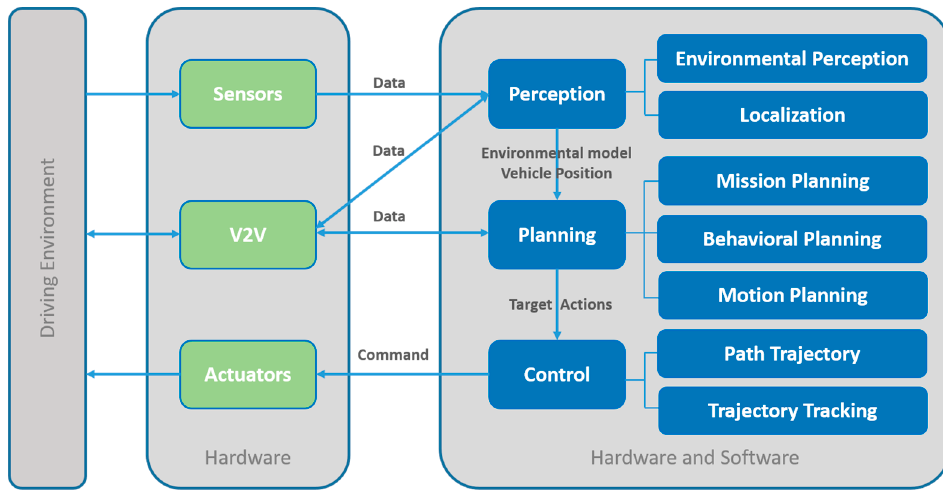
Figure 1. Typical autonomous vehicle system.